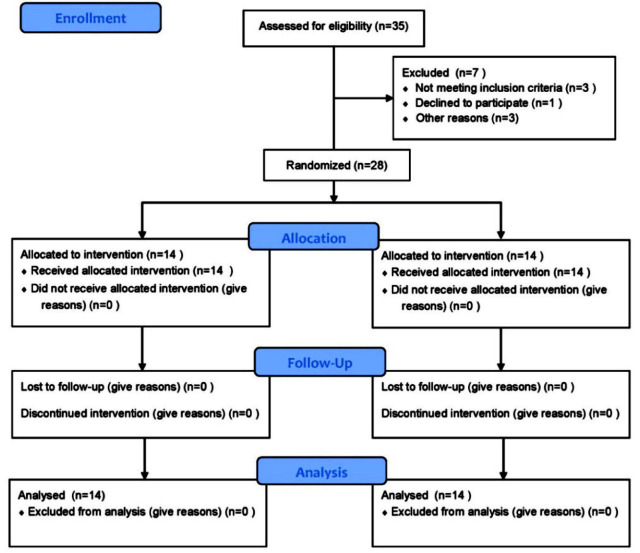
 CONSORT Flow Diagram